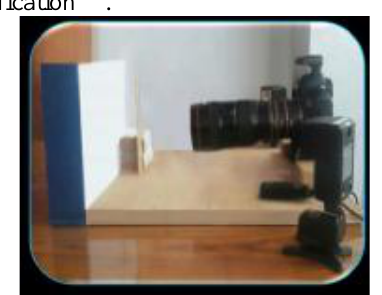
Figure 2: Specific Platform with